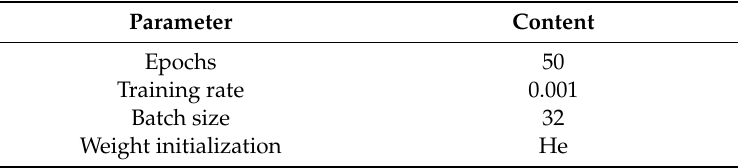
Table 2 lists the parameters of CNN. Table 2. Experiment parameters.